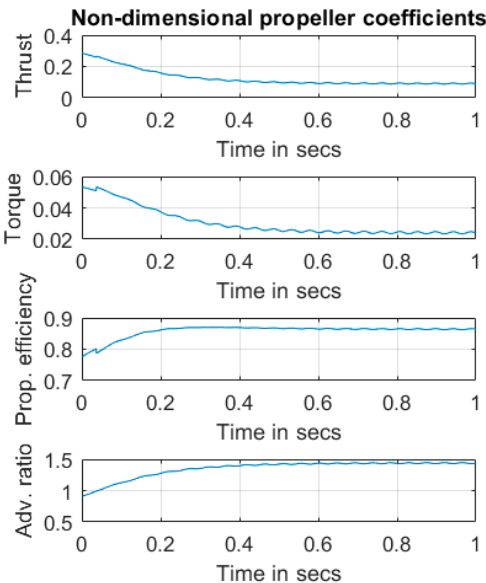
Figure 2. Variation of the PMSM load torque as a function of time over the timeframe of 1 s at normal room temperature.